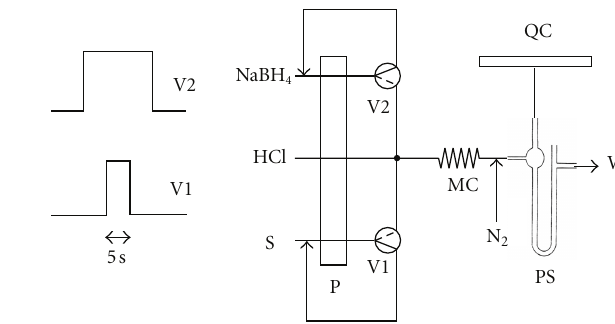
Figure 1: FIA system for total selenium determination by HG-AAS. S: sample; V: 6-port valve; P: peristaltic pump; MC: mixing coil (50cm); PS: phase separator; QC: quartz cell; W: waste.